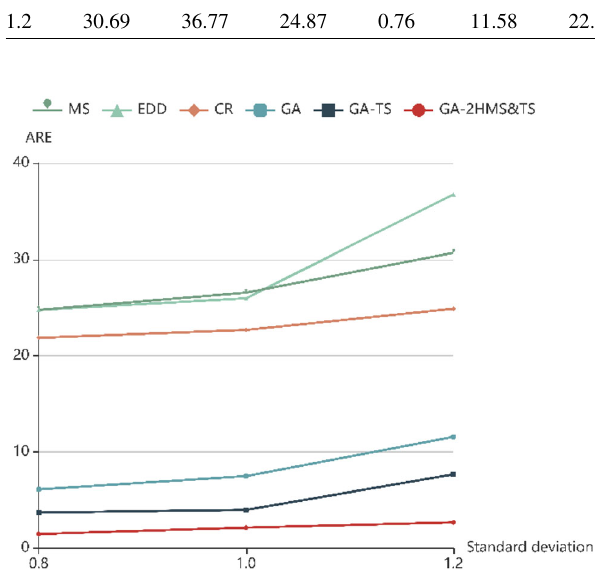
Fig. 8 ARE of different algorithms for different road conditions